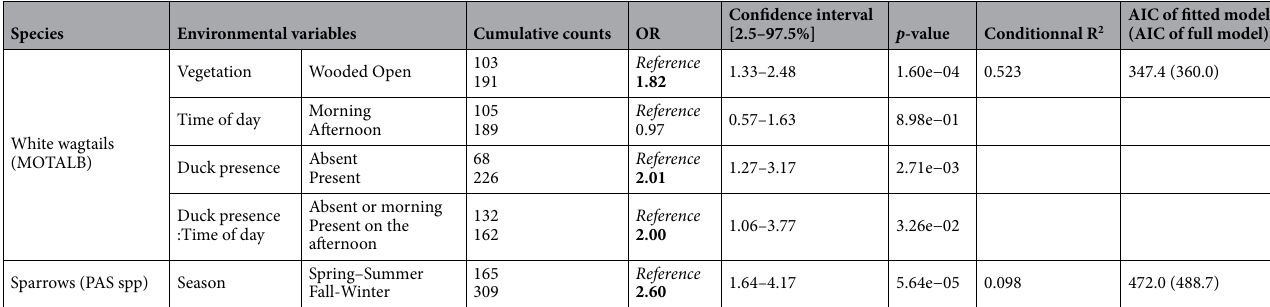
Table 2. Results of the negative binomial general linear mixed-effects models for White wagtails and Sparrows on duck foraging areas. For each species, counts per session are the response variable, and effects of explanatory environmental variables according to the minimal fitted model are detailed. For both species, the full model from which the AIC is given used the formula Logit(counts) = Vegetation*Season*Time of day*Duck presence with the Month as random effect. Significant values are in